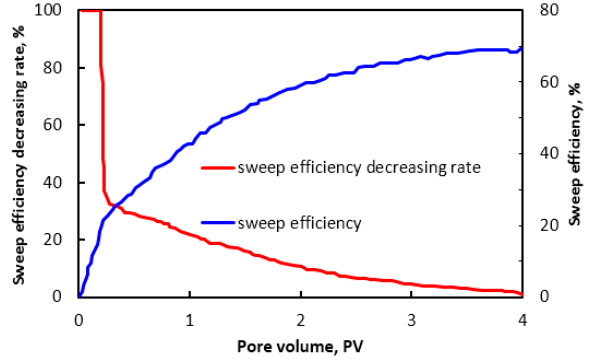
Figure 8. Sweep efficiency of waterflooding.